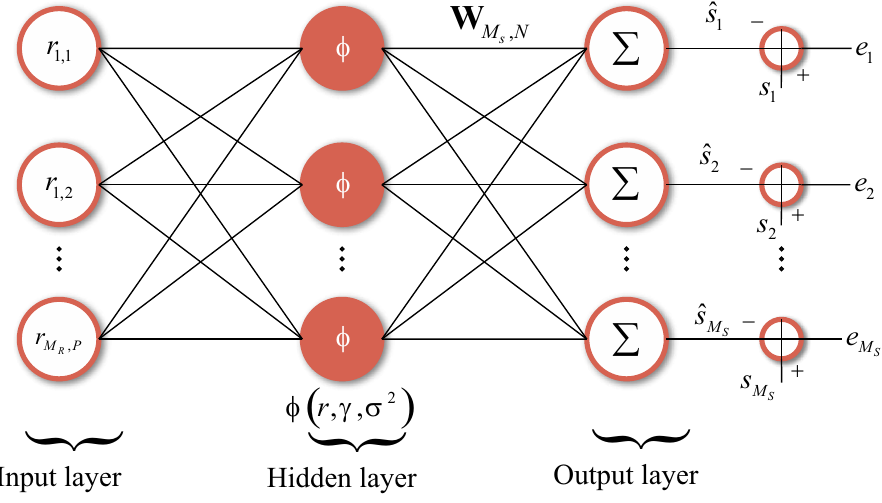
Figure 6. MIMO phase transmittance radial basis function neural network architecture